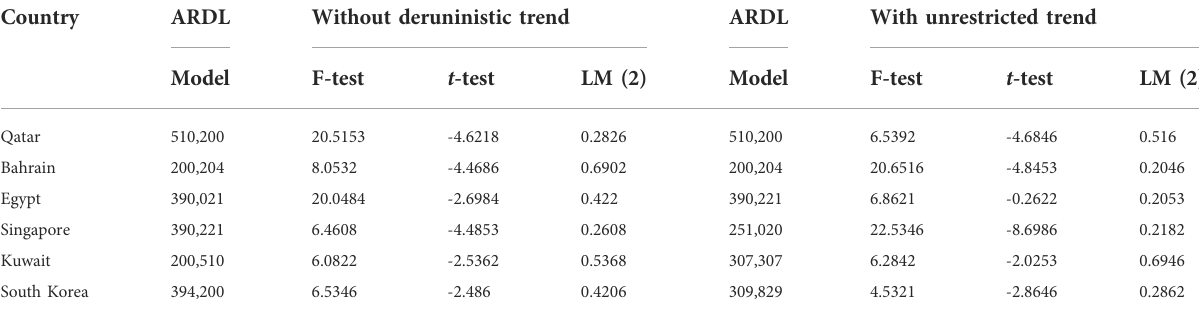
TABLE 5 Bound F-test results for Real Exchange Rate Model.